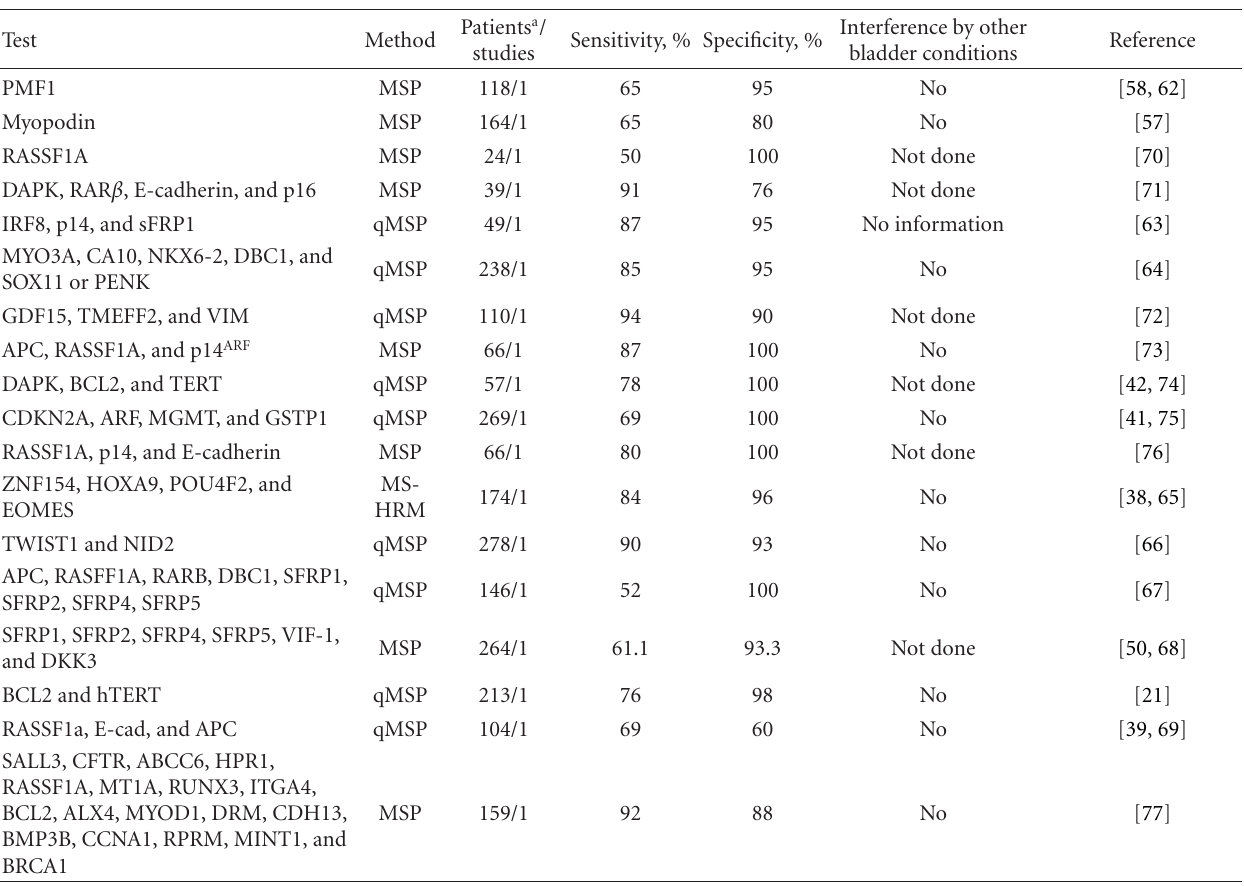
Table 3: Performance of DNA methylation markers in studies that include patients with suspicion of bladder cancer and patients previously diagnosed with bladder